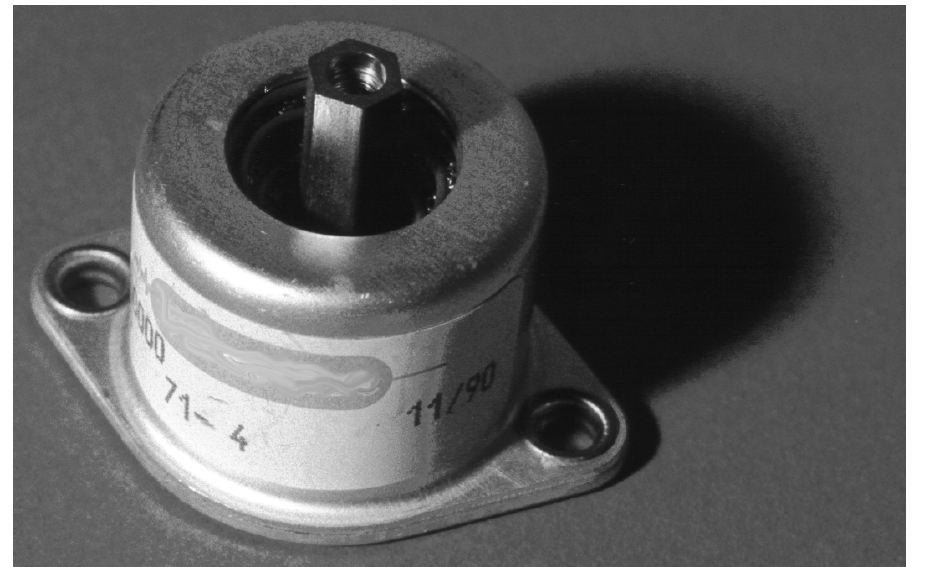
Fig. 3. Elastomer